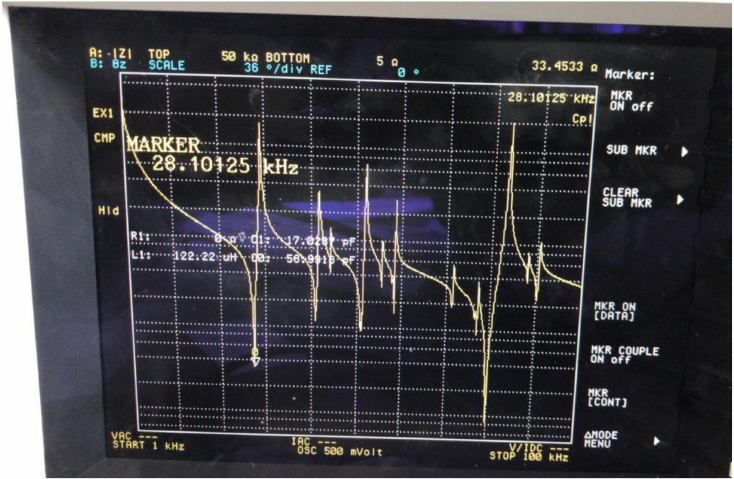
Figure 3. Non-marinised transducer, main resonance frequency is 28.1 kHz and 33.4 Ohms.